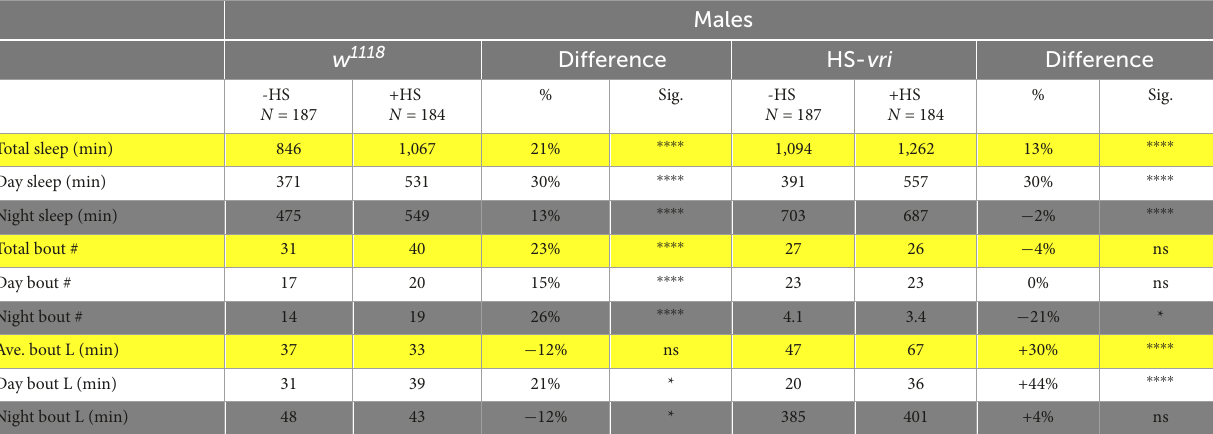
TABLE 1 Effect of HS- vri induction on sleep.